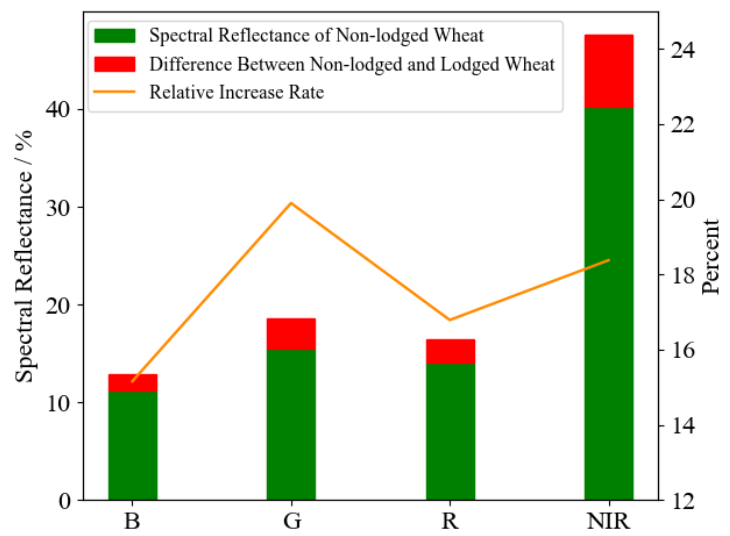
Figure 9. Increment of spectral reflectance of lodged wheat in each band, and relative increase rate of spectral reflectance of each band.